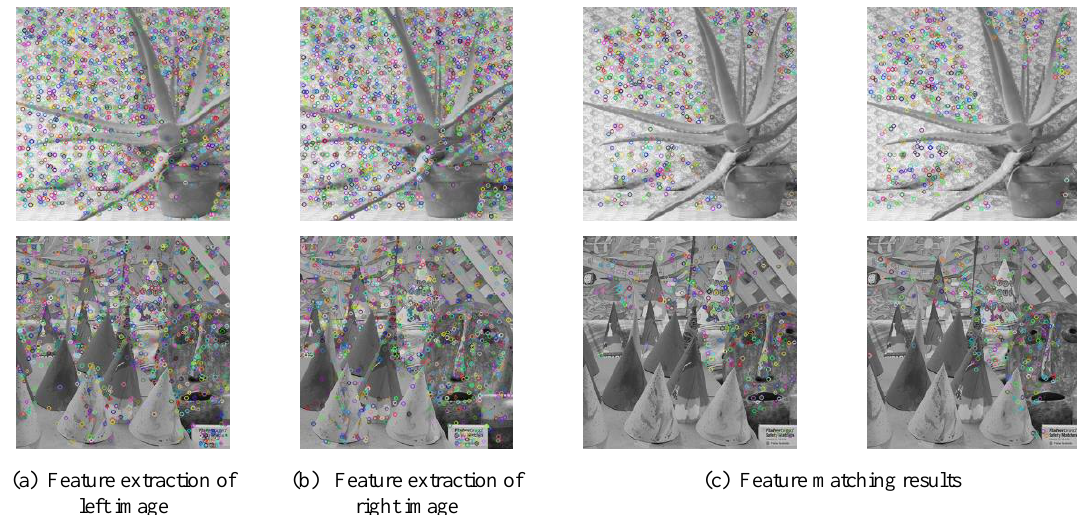
Figure 4. Feature extraction and matching results of Cones and Aloe